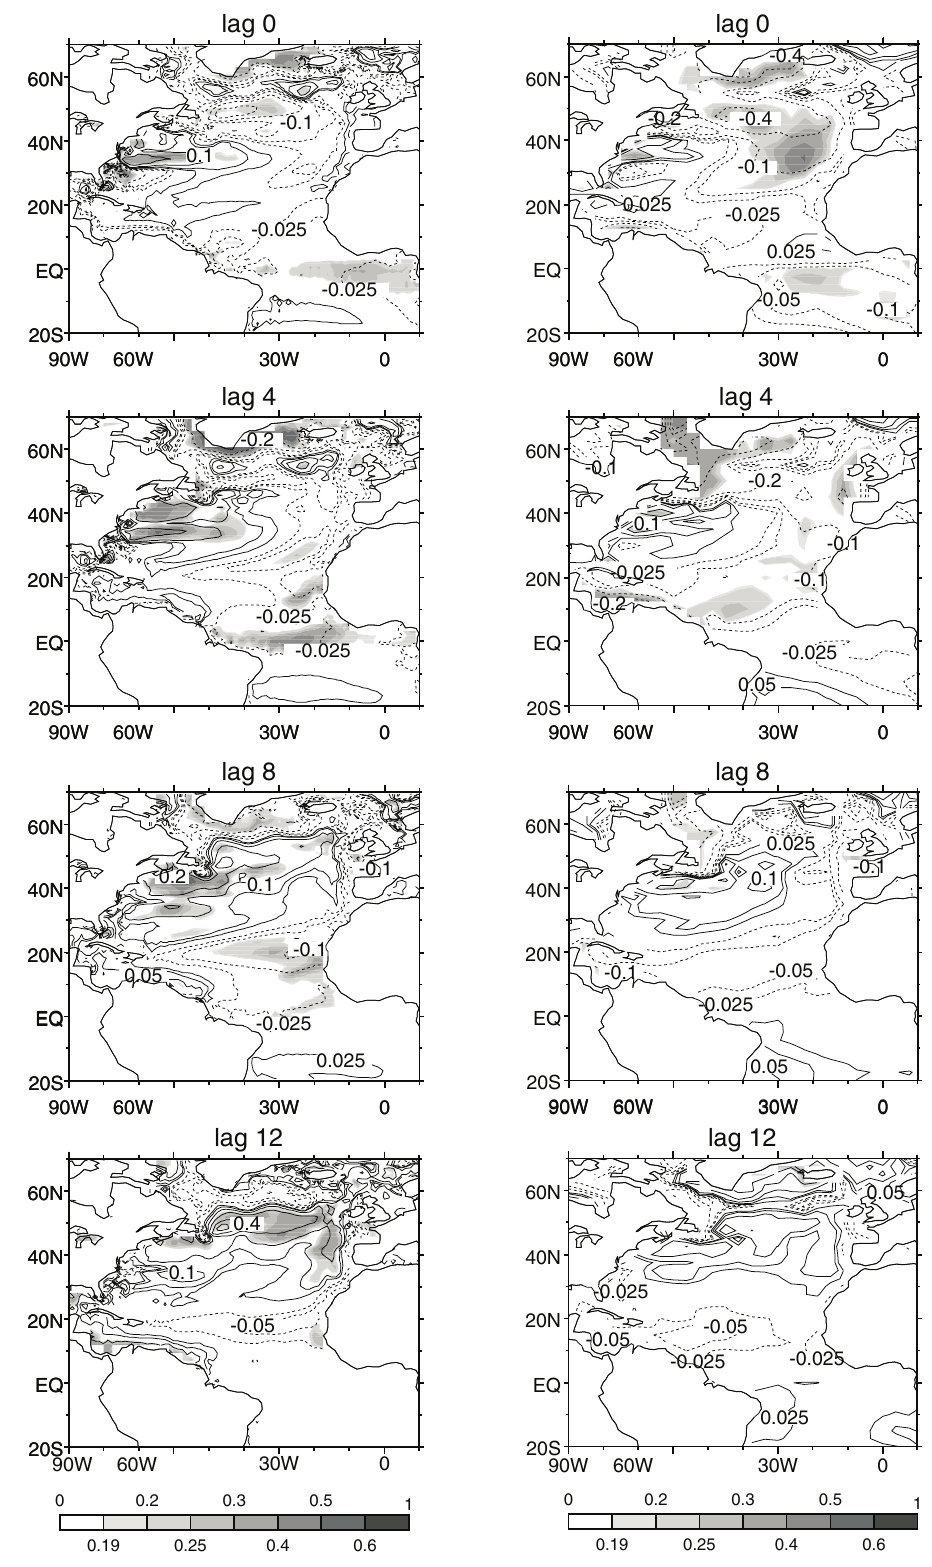
Fig. 3. Regression coefficients of the annual mean ocean heat content (left) and sea surface temperature (right) to the PC2 of the MOC at various lags for the HadCM3 simulation. Positive lags mean the MOC leading. Units are in o C per unit PC2 of the MOC. Shading scale indicates explained local